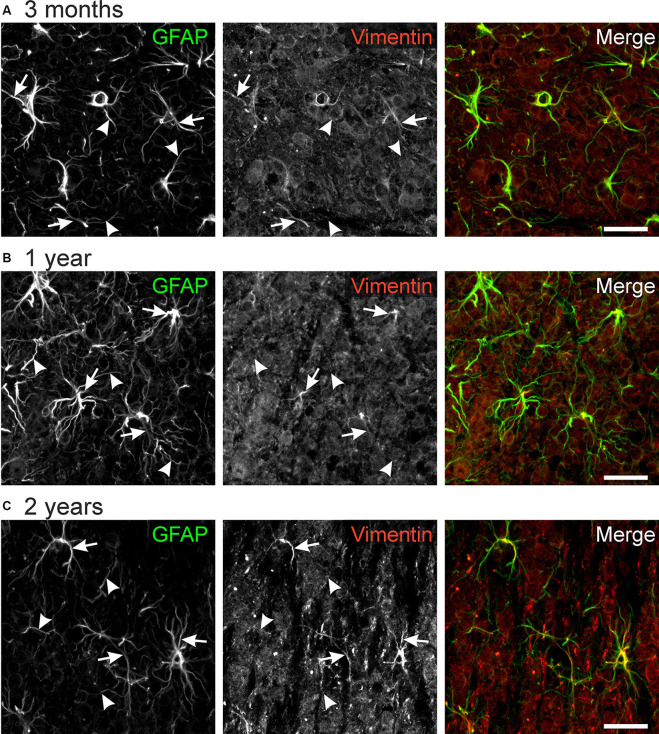
GFAP-vimentin colocalization in the mouse olfactory bulb. Anti-GFAP (green) and anti-vimentin (red) immunoreactivity colocalizes in some astrocyte processes (arrows), while most GFAP-positive processes were vimentin-negative (arrowheads). This result was observed in mice of the age of 3 months (A), 1 year (B), and 2 years (C). Scale bar: 20 μm.